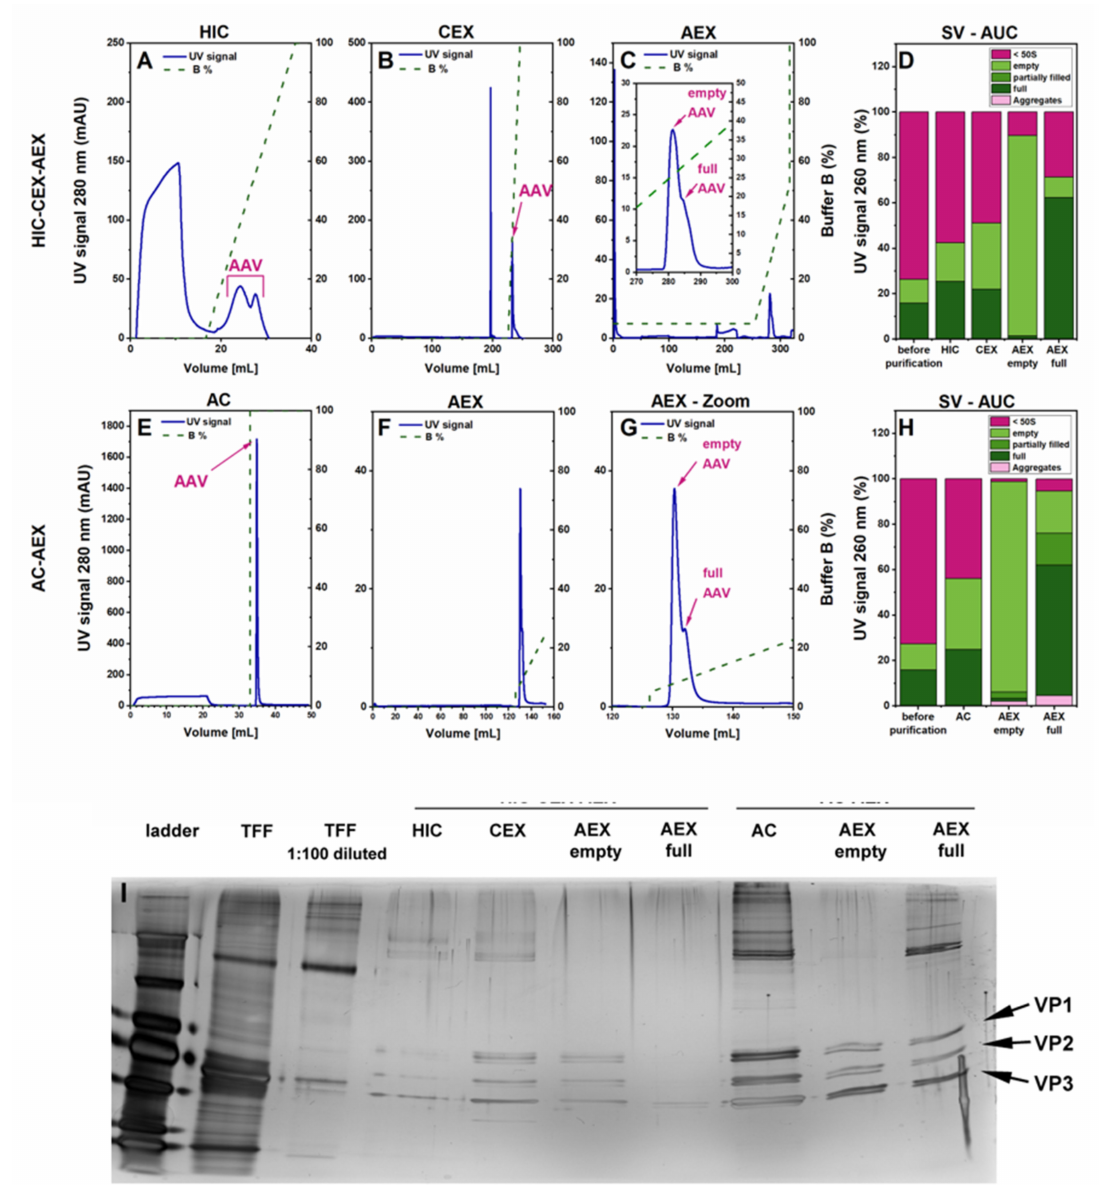
Figure 2. Comparison of HIC-CEX-AEX and AC-AEX for purification of the rAAV2/8 vectors. Each chromatogram shows the respective ultra-violet (UV) signal in blue (scale on the left Y -axis) and the concentration of buffer B depicted as a dashed green line (scale on the right). ( A – C ) Chromatograms obtained with HIC-CEX-AEX in three subsequent steps on a HIC ( A ), a CEX ( B ), and an AEX ( C ) column. ( D ) SV-AUC analysis of rAAV2/8 of the indicated samples from different purification states. ( E , F ) Chromatograms obtained with AC-AEX in two subsequent steps on an AC ( E ) and an AEX ( F ) column. ( G ) Magnification view of the AEX chromatogram shown in F (focusing on the 120–150-mL range) to better visualize the peaks of the empty and full rAAVs. ( H ) SV-AUC analysis after AC and AEX. ( I ) Silver-stained sodium dodecyl sulfate polyacrylamide gel electrophoresis (SDS-PAGE) of the rAAV material after TFF, and the intermediate steps from the purification downstream processes HIC-CEX-AEX and AC-AEX. AC, affinity chromatography; AEX, anion exchange chromatography; CEX, cation exchange chromatography; HIC, hydrophobic interaction chromatography; PEG, polyethylene glycol; rAAV, recombinant adeno-associated virus; TFF, tangential flow filtration; VP, viral